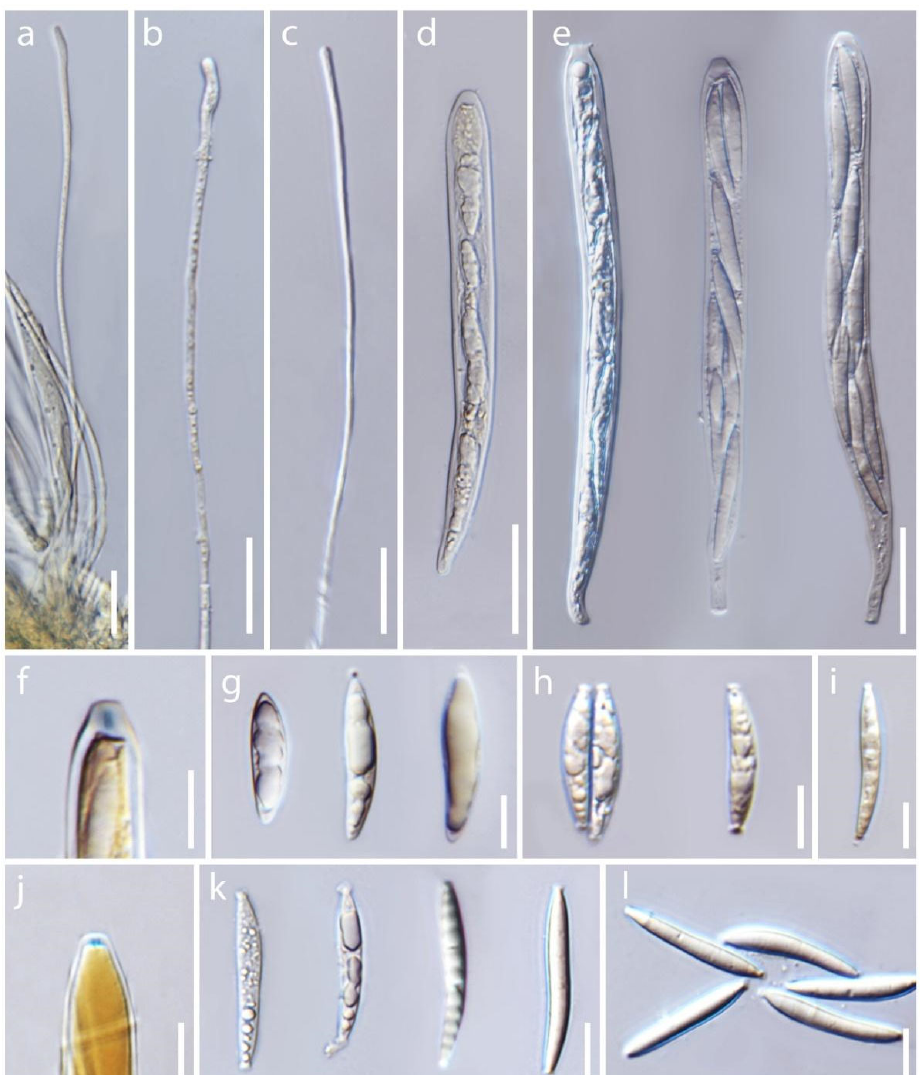
Figure 10. Asci and ascospore characteristics of Dicephalospora rufocornea . (a–c) Filiform paraphyses; ( a ) MFLU 19-2083 in Melzer’s reagent; ( b ) MFLU 19-2085; ( c ) MFLU 19-2083; ( d , e ) ascospores; ( d ) MFLU 19-2083; ( e ) MFLU 19-2082; ( f ) amyloid ascal apex in Melzer’s reagent (MFLU 19-2089); ( g , h ) ellipsoidal to fusiform ascospores; ( g ) MFLU 19-2071; ( h ) MFLU 19-2085; ( i ) fusiform ascospores (MFLU 19-2073); ( j ) amyloid ascal apex in Melzer’s reagent (MFLU 19-2071); ( k , l ) fusiform ascospores; ( k ) MFLU 19-2083; ( l ) MFLU 19-2087. Scale bars ( a – c ) = 20 µ m; ( d , e ) = 30 µ m; ( f – l ) = 10 µ m. Dicephalospora rufocornea (Berk. and Broome) Spooner (Figures 8–10). Index Fungorum number: IF130937; Facesoffungi number:—FOF05900. Saprobic on dead stems. Sexual morph: Apothecia 0.5–4 × 0.3–3 µ m ( x = 1 × 0.7 µ m, n = 60), when dry arise solitary or gregarious in a small group, scattered on wood, super- ficial, are yellow to orange when fresh, and become red when dry, with centrally short stipitate. The stipe is 400–700 µ m ( x = 500 µ m, n = 60) and dark at the base. The receptacle is cupulate. The disc is flat to concave and orange or red wine. Margins are orange or red more than the disc, and smooth. The ectal excipulum is 65–140 µ m ( x = 95 µ m, n = 50) Disc concave with unbranched paraphyses…………..….…….………..….…. D. sessilis and multi-layered, with hyaline to light orange cells of textura prismatica or textura epi- ‐ Disc slightly convex with branched paraphyses………..….…………..…. D . irregularis dermoidea. The medullary excipulum is 60–100 µ m ( x = 75 µ m, n = 50), multi-layered, and hyaline to light orange, with cells of textura intricata. The hymenium is yellow rather than light orange and inter mixed with asci and paraphyses. Paraphyses are 2–3 µ m